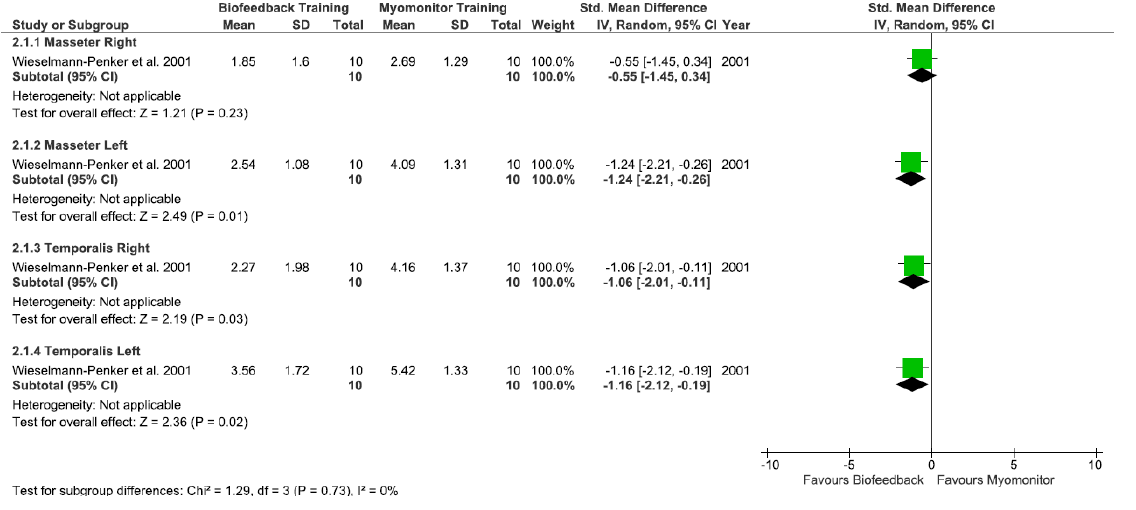
Figure 4. EMG activity per muscle: Visual feedback vs. Myomonitor (TENS) evaluated through EMG activity [34]. Table 3. GRADE “Biofeedback compared to Myomonitor Training for Awake Bruxism”.